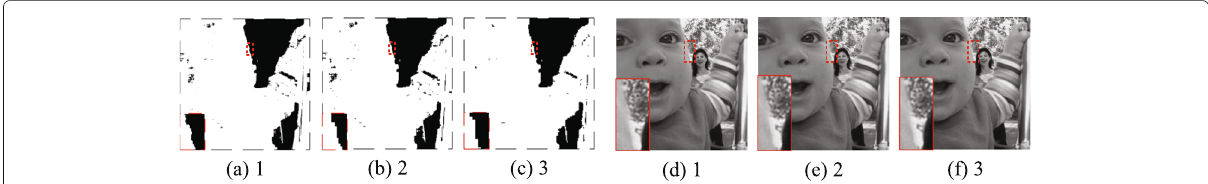
Fig. 10 Influence of distinct steps on fused images. Number represents the step sizes. Different steps of overlapping extract blocks will be affecting the results of the proposed method